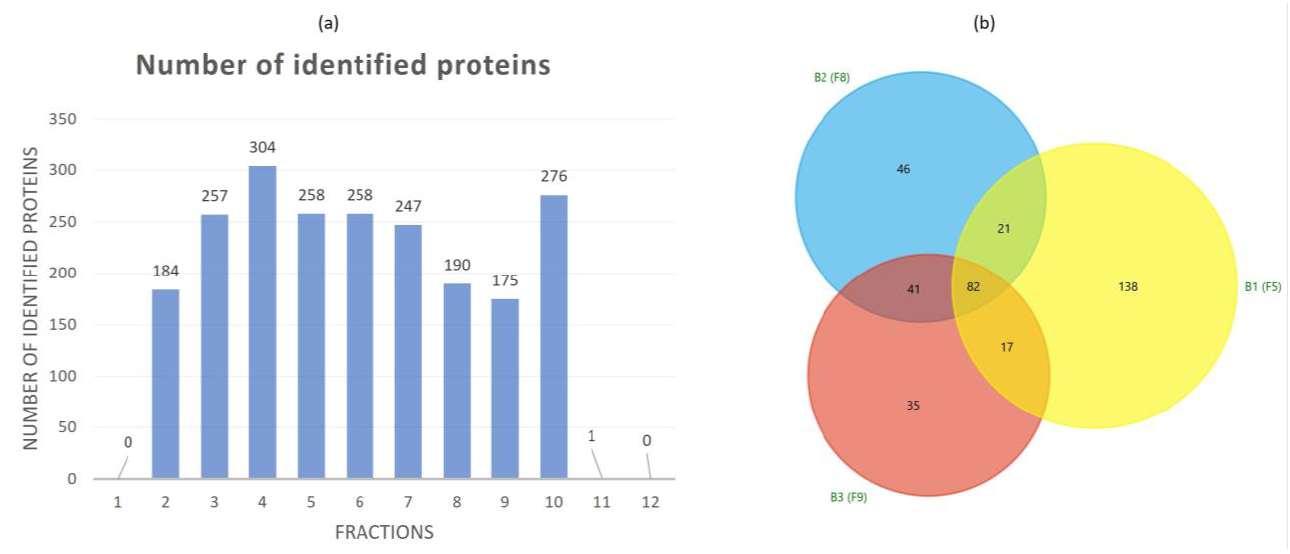
Figure 3. ( a ) Number of total identified proteins in each fraction separated by iodixanol density gradient ultracentrifugation (DGUC); ( b ) Venn diagram of the proteins identified in the proteomics study showing a similarity between the identified proteins in different DGUC fractions.